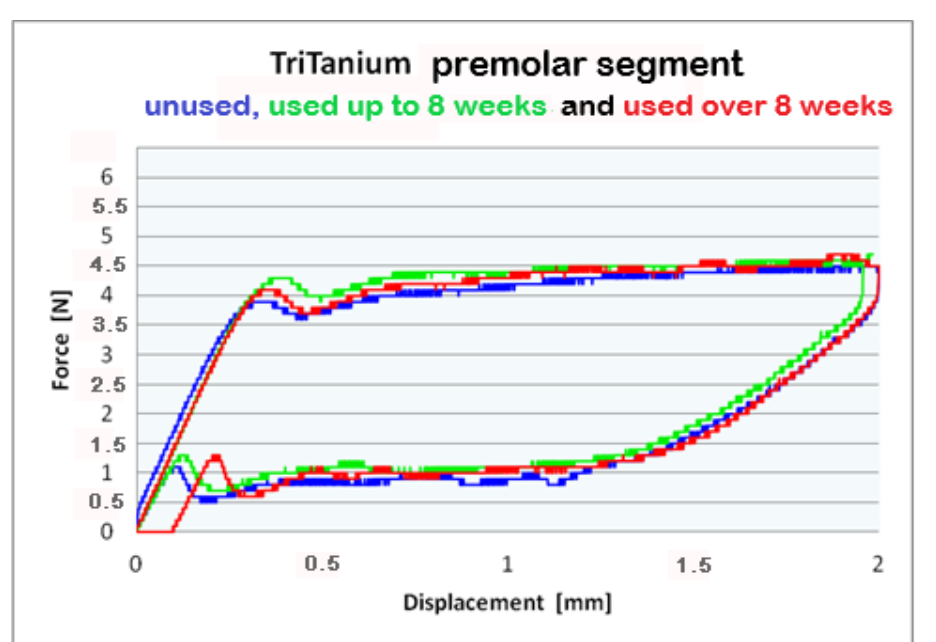
Figure 6. Combined force/deformation curve graphs for period G 0 (blue), G 1 (green) , G 2 (red), premolar segment for the TriTanium ® archwire.